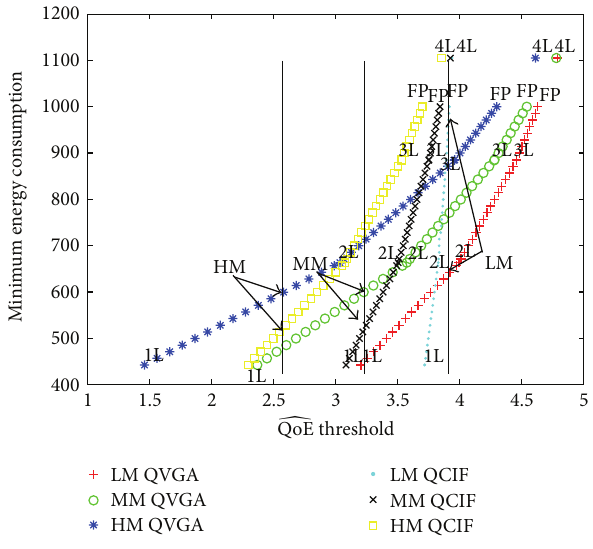
Figure 2: Static versus dynamic energy optimization for different CTs and